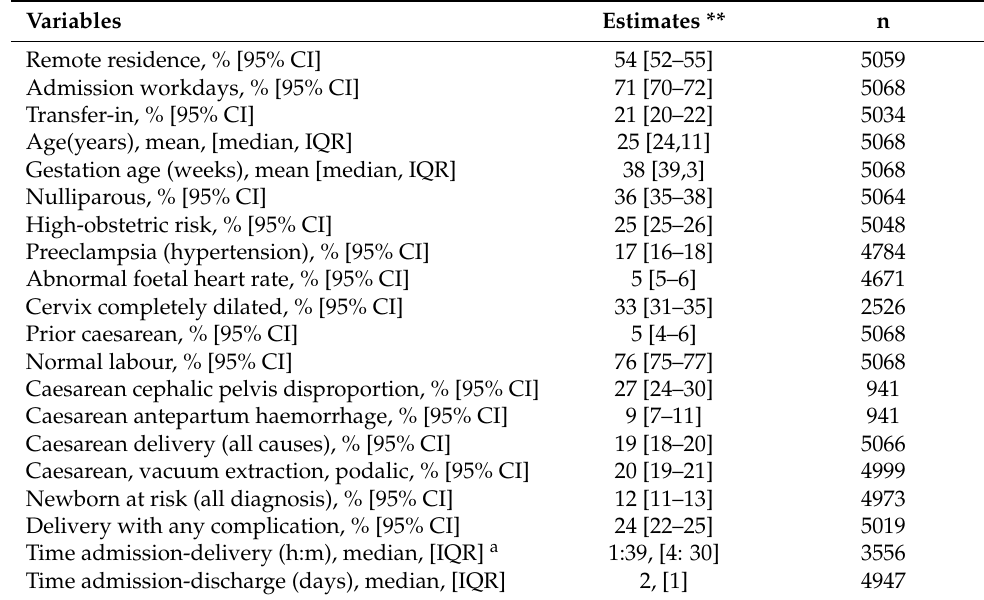
Table 2. Selected sample characteristics, Chicuque , Chokwe and Manhiça hospitals